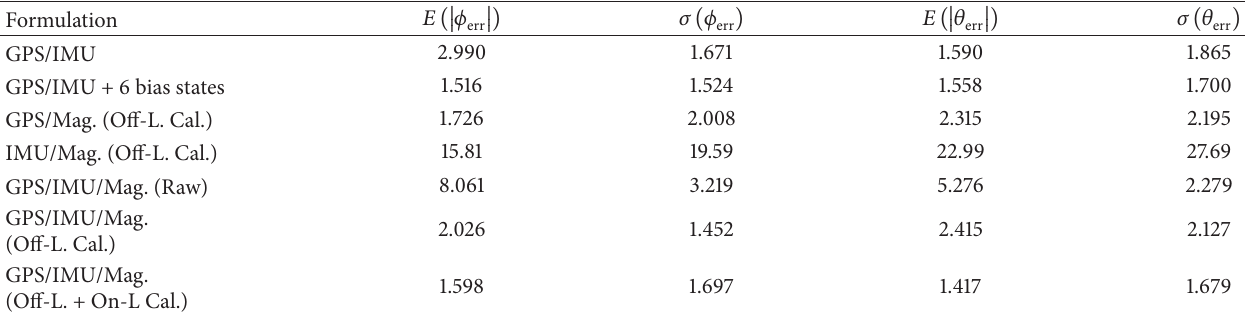
Table 1: Statistics of attitude estimation algorithms.